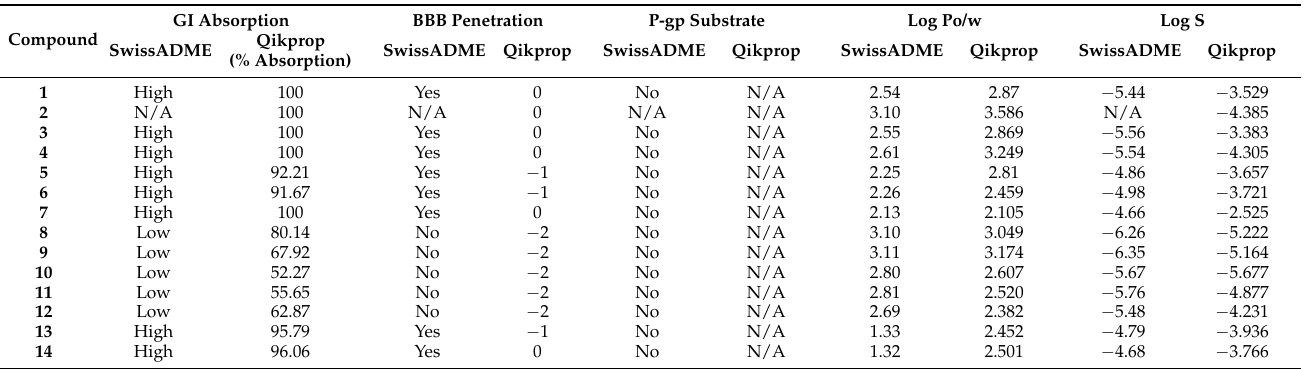
Table 5. Predictions of the ADME properties for the 14 N-heterocycle derivatives using SwissADME and QikProp computational